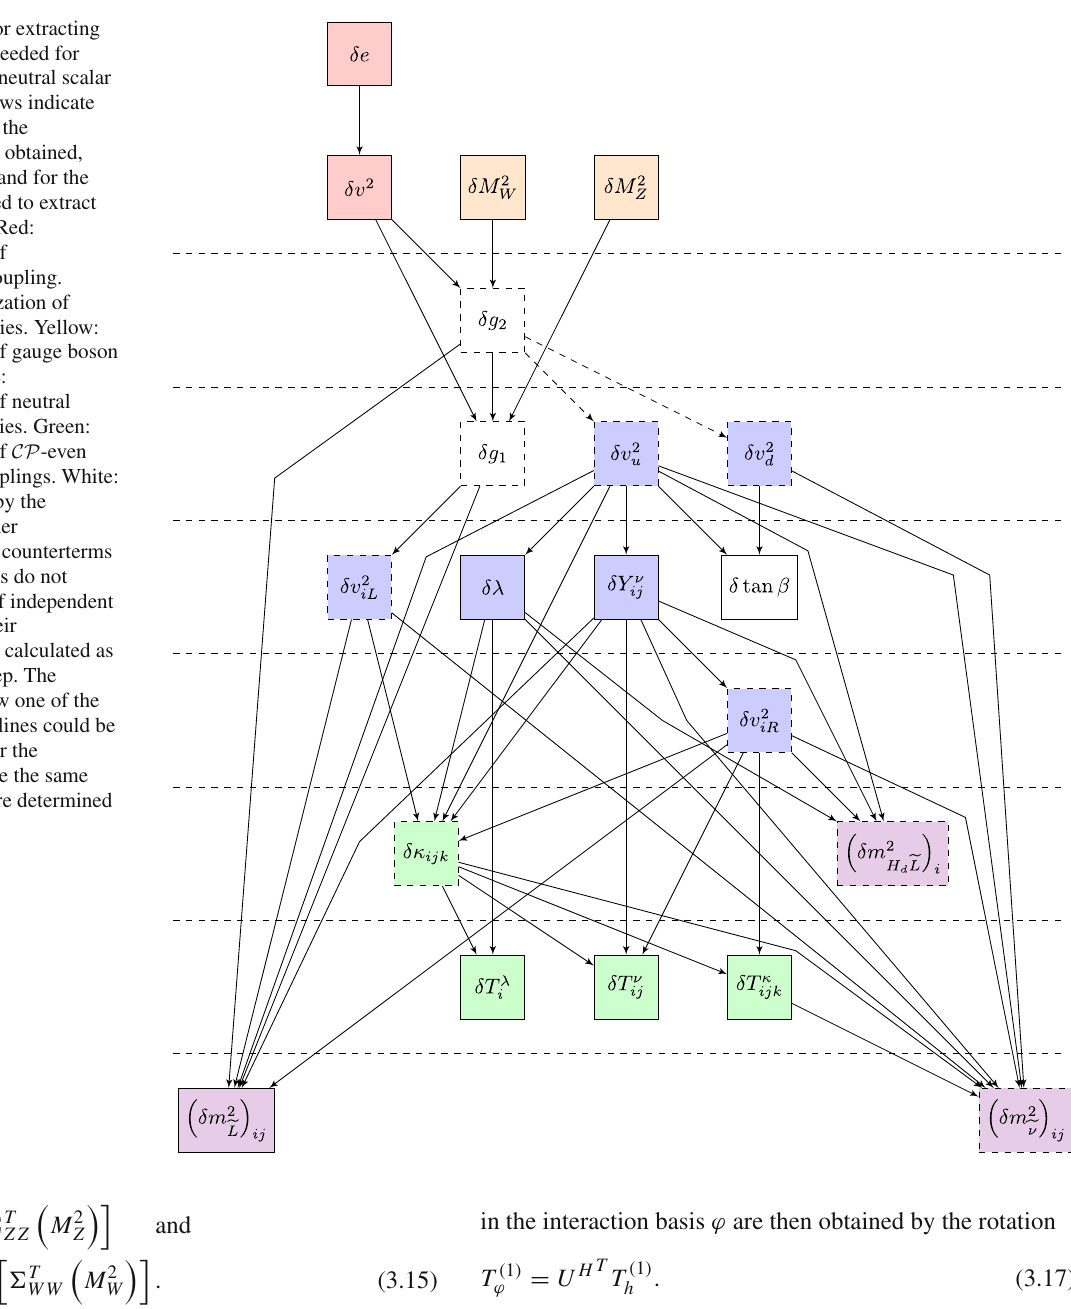
Fig. 1 Strategy for extracting the counterterms needed for renormalizing the neutral scalar potential. The arrows indicate the order in which the counterterms were obtained, while the colors stand for the sector that was used to extract the counterterms. Red: Renormalization of electromagnetic